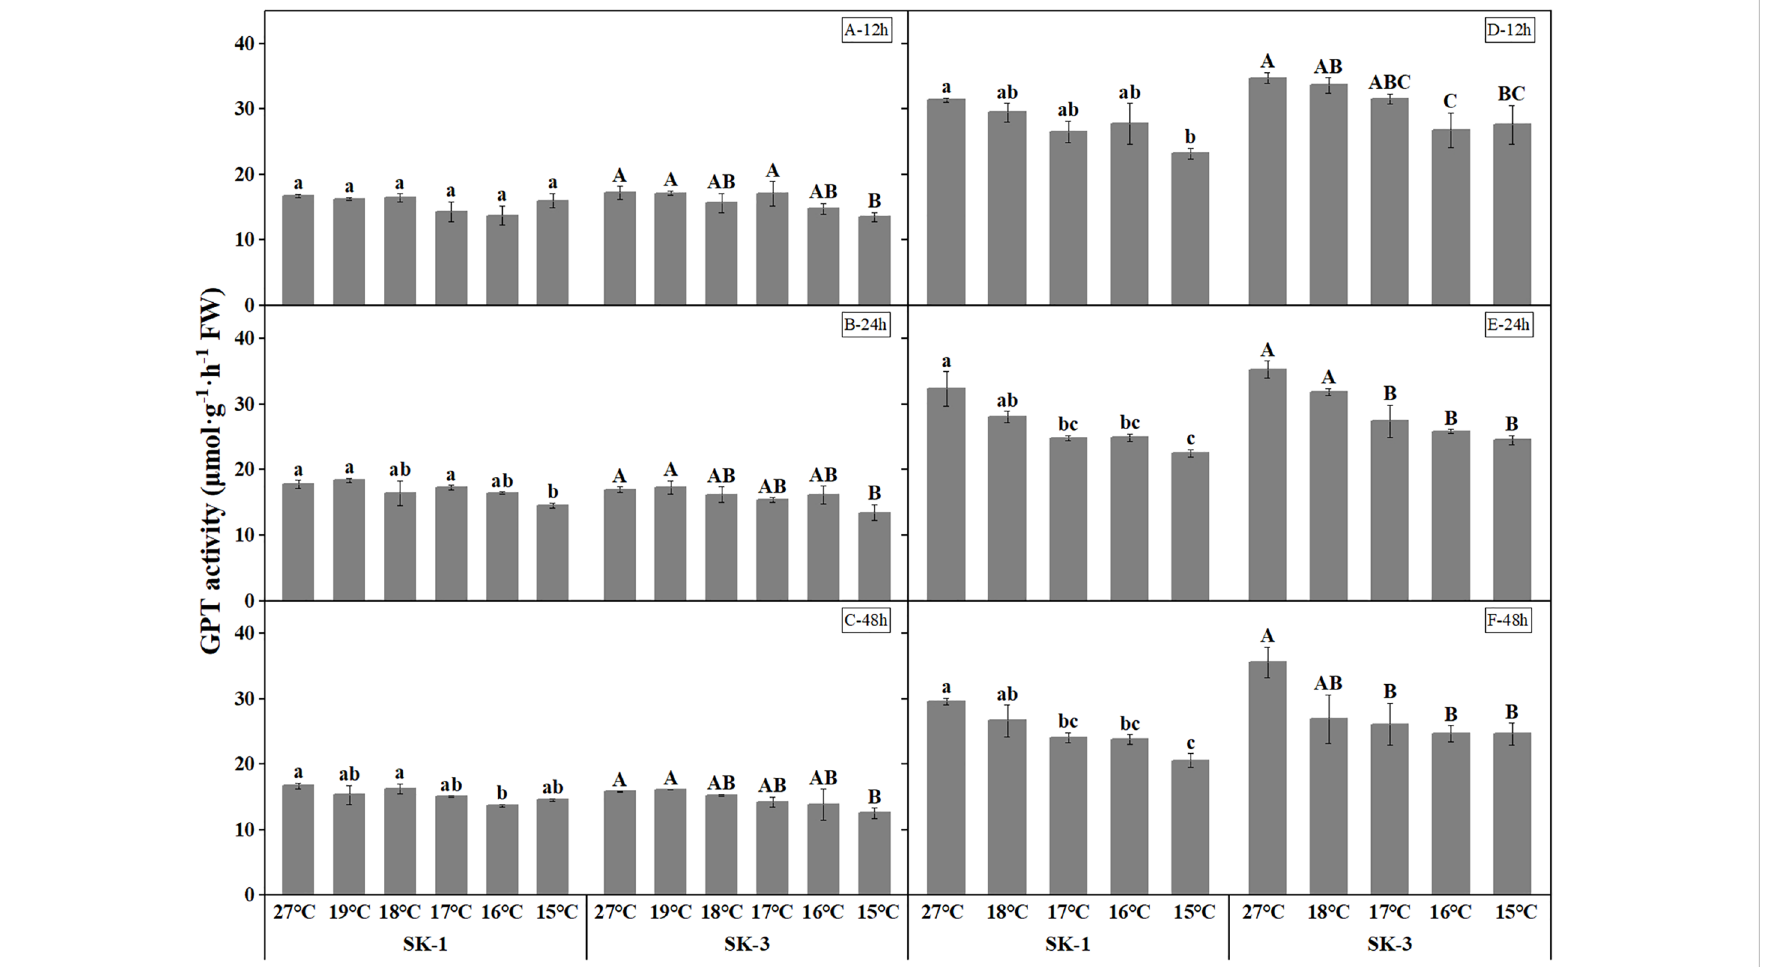
FIGURE 10 Effect of low temperature stress on GPT activity in cotton squares in 2020 ( A-C : 12h, 24h, 48h stress) and 2021 ( D-F : 12h, 24h, 48h stress). FW represents fresh weight. Different lowercase letters indicate the signi fi cant differences between the treatments of the variety SK1, and different capital letters indicate the signi fi cant differences between the treatments of the variety SK3